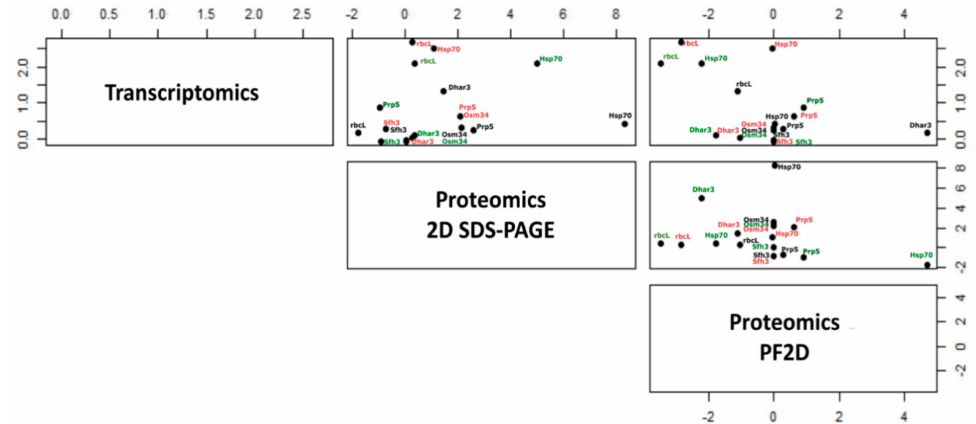
Figure 7. Scatterplot matrix of the independent variables: transcriptome, proteome with 2D-PAGE, and proteome with PF2D. The three-dimensional scatterplot represents the correlation among gene expression, protein abundance with 2D-PAGE and protein abundance with Pf2D. The lines are represented in black for wt, in red for atnp 01, and in green for atnp 02. Transcriptomics data are taken from array analysis in Marmiroli et al. [14], and proteomic with PF2D data from Marmiroli et al. [25]. Each point represents a protein/transcript for the different plant lines using colors as